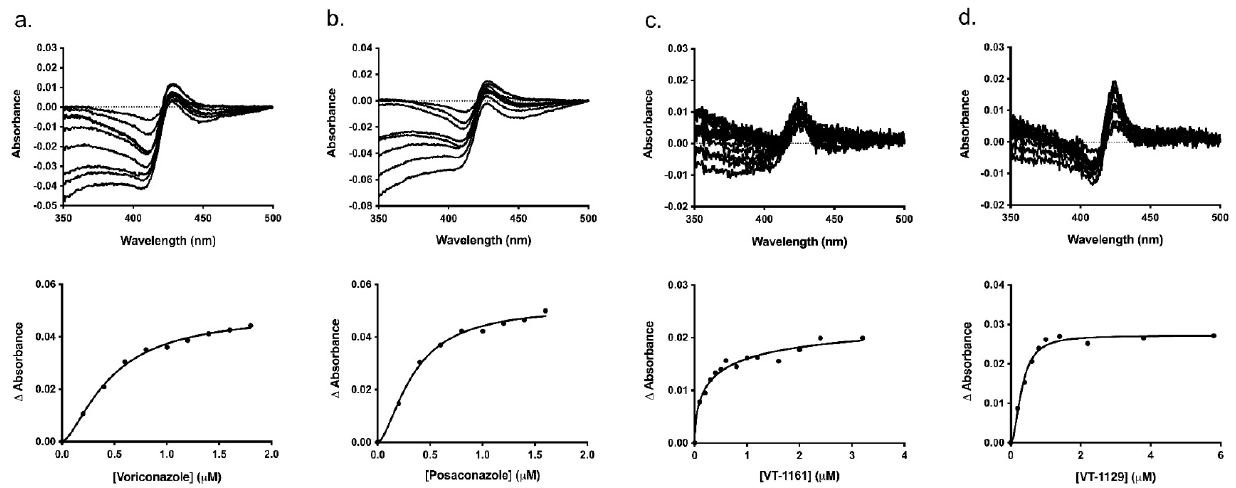
Figure 6. Type II binding spectra and binding curves of CpCYP51-6×His. The curves with best fit were obtained using Hill equation for the binding of the azoles to CpCYP51-6×His. ( a ) VCZ, ( b ) PCZ, ( c ) VT-1161, ( d ) VT-1129. VCZ was dissolved in Milli-Q water. PCZ, VT-1161 and VT-1129 solutions were prepared in DMSO. Table 2. Type II binding of azoles to CpCYP51-6xHis.